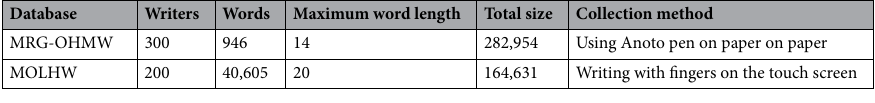
Table 1. Statistics of MRG-OHMW and